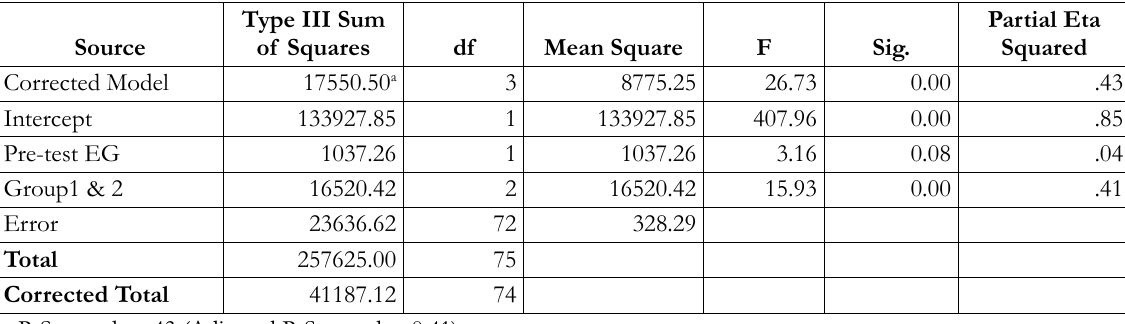
Table 4. ANCOVA summary of post-tests EG and CG with pre-tests as the covariate The EG pre-test performances of males and females were tested using a Mann Whitney U-test (Table 5).